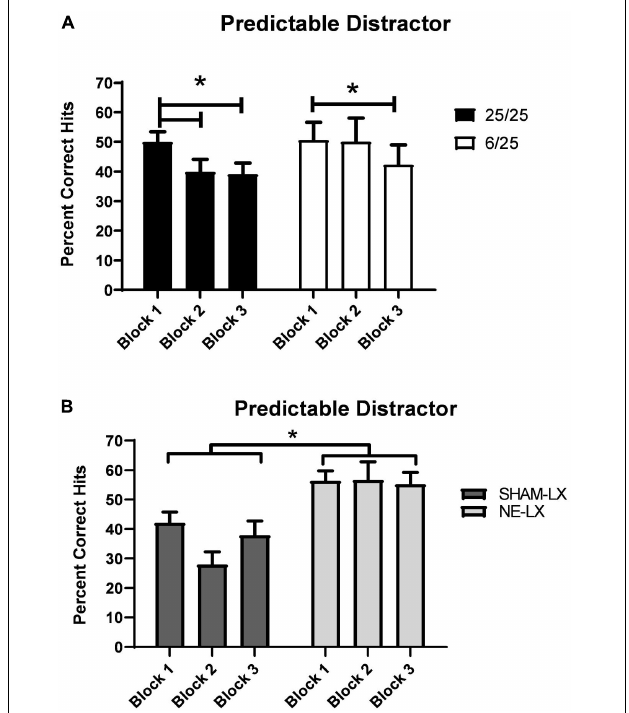
FIGURE 4 | (A) 6/25 rats (white bars) were more resistant to cognitive fatigue produced by the presence of a 0.5 Hz visual distractor than 25/25 rats (black bars). Prenatally protein malnourished rats did not show a significant decline in performance under these conditions until the last block of trials. In contrast, 25/25 rats were significantly impaired in detecting signals by Block 2 and their signal detection remained impaired throughout the rest of the testing session. (B) Rats with selective noradrenergic lesions of the PL cortex (light gray bars) were more resistant to the effects of a 0.5 Hz visual distractor than controls (dark gray bars) as shown by the higher number of hits (ordinate) over the course of the testing session. ∗ indicates p <